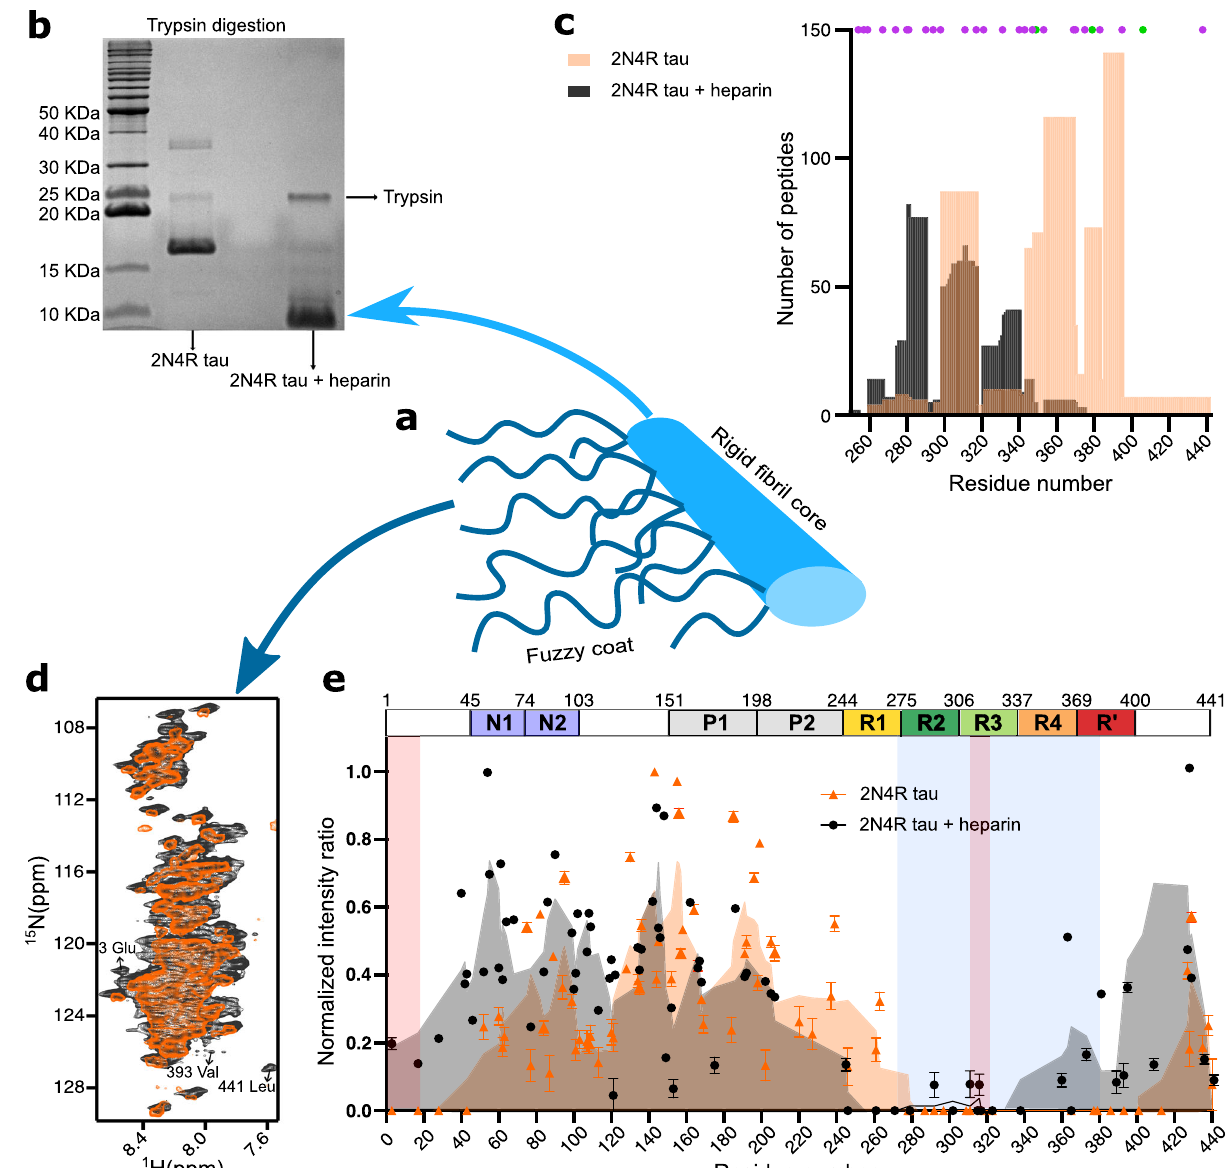
Fig. 2 Heparin-free tau fi brils have an extended core and an immobile N-terminal antibody-binding epitope. a Cartoon representation of the rigid core and dynamic (termed fuzzy) coat of tau fi brils. b SDS-PAGE gel of trypsin-digested tau fi brils formed in the absence or presence of heparin. The trypsin band is indicated. The result was reproducible for three independently performed experiments. c Number of peptides detected from the enzymatic digestion of the tau bands observed in SDS-PAGE in ( a ). The position of lysine and arginine residues of 2N4R tau are marked with purple and green dots, respectively. d Superposition of 1 H- 15 N INEPT spectra of 2N4R tau fi brils aggregated in the absence (orange) and presence (black) of heparin. e Intensity ratio plot of 2N4R tau fi brils aggregated in the absence (orange) and presence (black) of heparin. The intensity ratio was calculated by dividing the signal intensity of each residue in the fi bril state by the monomeric state. The error of the intensity ratio for each residue was calculated from the signal-to-noise ratio of the cross peaks in the spectra. The rigid cross-ß-sheet core of the tau fi bril extracted from a CBD patient brain (PDB code: 6TJO) is marked in light blue. The two discontinuous epitopes (residues 1 – 18 and residues 313 – 322) of antibodies that speci fi cally detect pathological tau 18 are marked by red